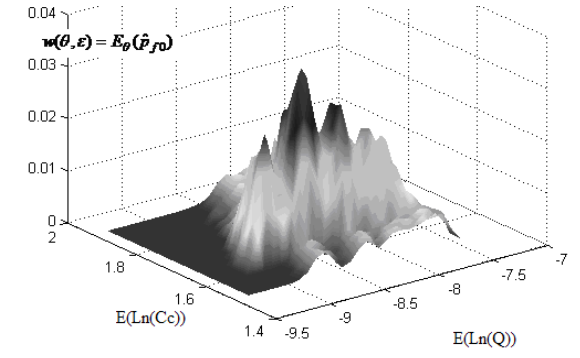
Fig 5. Numerical example for ε =